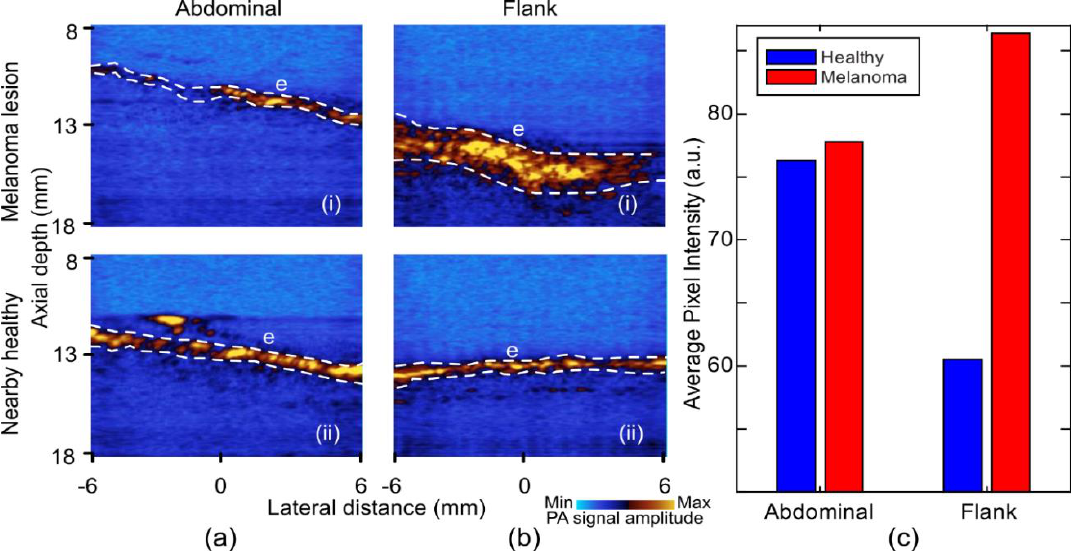
Figure 6. Photoacoustic images of melanoma lesion and nearby healthy skin at 532 nm illumination wavelength. ( a ) Abdominal: (i) Lesion and (ii) healthy. ( b ) Flank: (i) Lesion and (ii) healthy. ( c ) Bar chart of average pixel intensity from epidermal region in the PA images of 532 nm. E: Epidermis. Epidermal pixels (white dashes). The PA signal was increased in the melanoma, highlighting the increase in melanin.